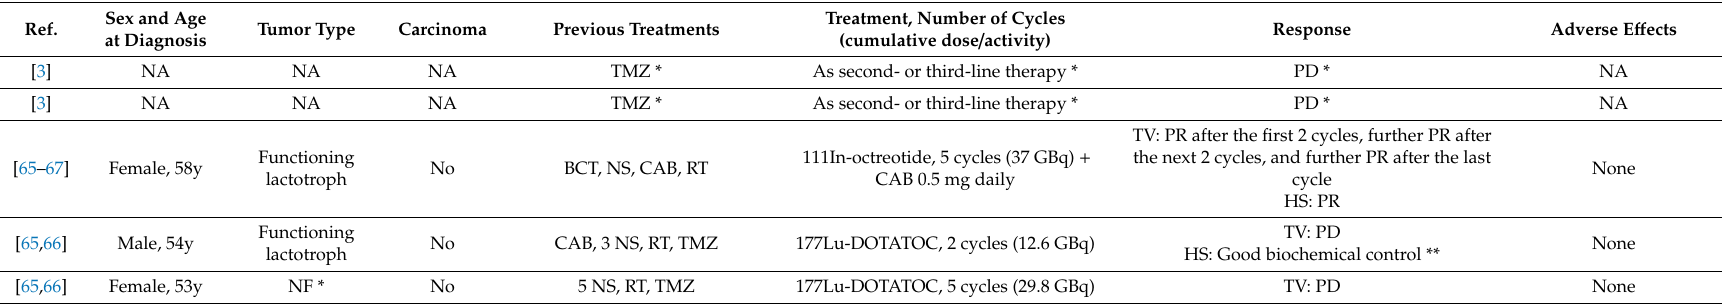
Table 5. Cases of aggressive pituitary neuroendocrine tumors and pituitary carcinomas treated with peptide receptor radionuclide therapy (PRRT).